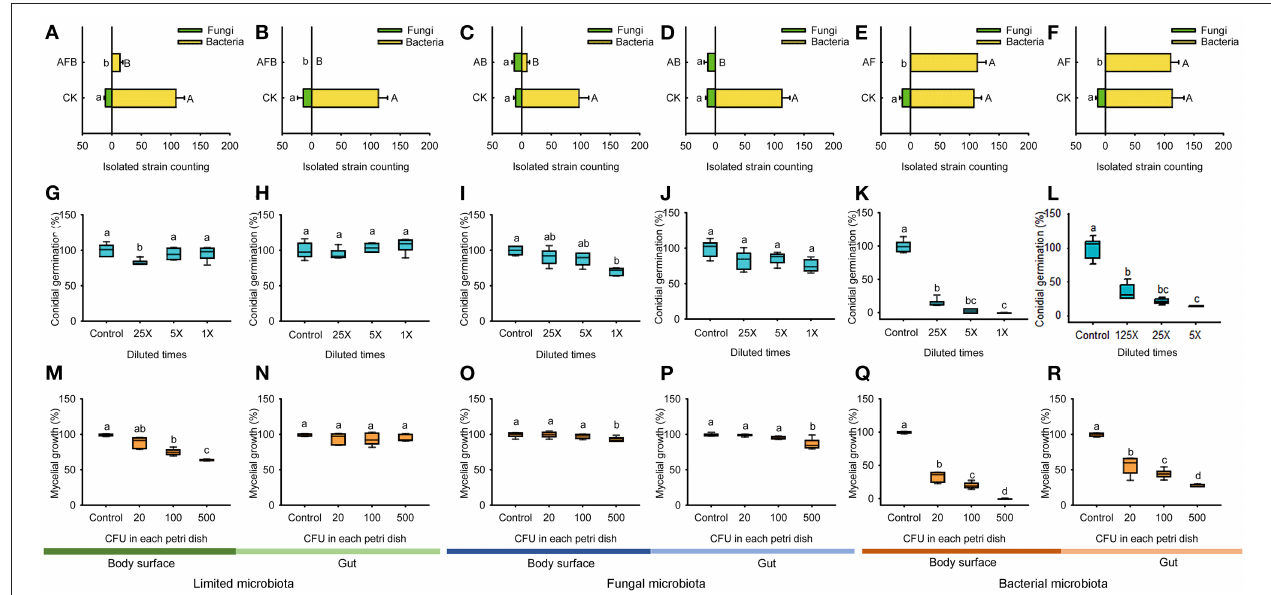
FIGURE 5 | Conidial germination and mycelial growth of B. bassiana BB1101 under the effects of limited microbiota, bacterial microbiota, and fungal microbiota. (A–F) Bacterial or fungal counting of diluted microbiota suspension from body surface limited microbiota, gut limited microbiota, body surface fungal microbiota, gut fungal microbiota, body surface bacterial microbiota, and gut bacterial microbiota. CK, without antibiotic; AFB, antifungal and antibacterial; AB, antibacterial; AF, antifungal. Different letters beside the bars in (A–F) refer to significant difference of microbial counting between the antibiotic treatment group and the control group (capital letters for bacteria, and lowercase letters for fungi. Independent t -test or Mann–Whitney U test, p < 0.05). (G–L) Conidial germination of B. bassiana BB1101 under the effects of body surface limited microbiota, gut limited microbiota, body surface fungal microbiota, gut fungal microbiota, body surface bacterial microbiota, and gut bacterial microbiota, respectively. (M–R) Mycelial growth of B. bassiana BB1101 under the effects of body surface limited microbiota, gut limited microbiota, body surface fungal microbiota, gut fungal microbiota, body surface bacterial microbiota, and gut bacterial microbiota, respectively. Different letters above each box refer to significant differences within each set of boxes (one-way or Welch’s ANOVA, p < 0.05, n = 6).